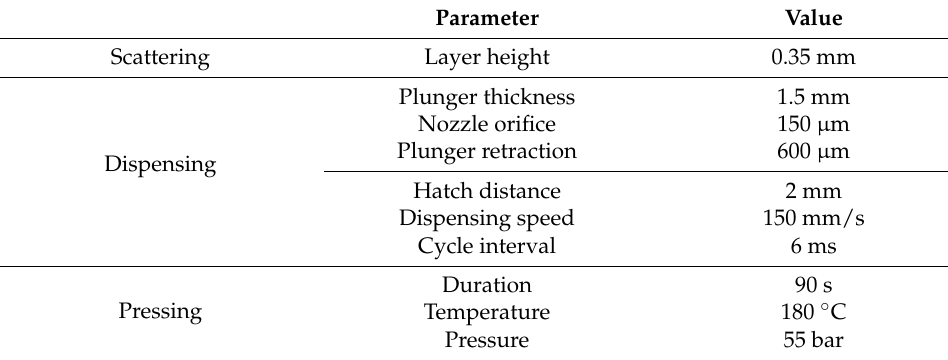
Table 1. Production parameters of the rectangular